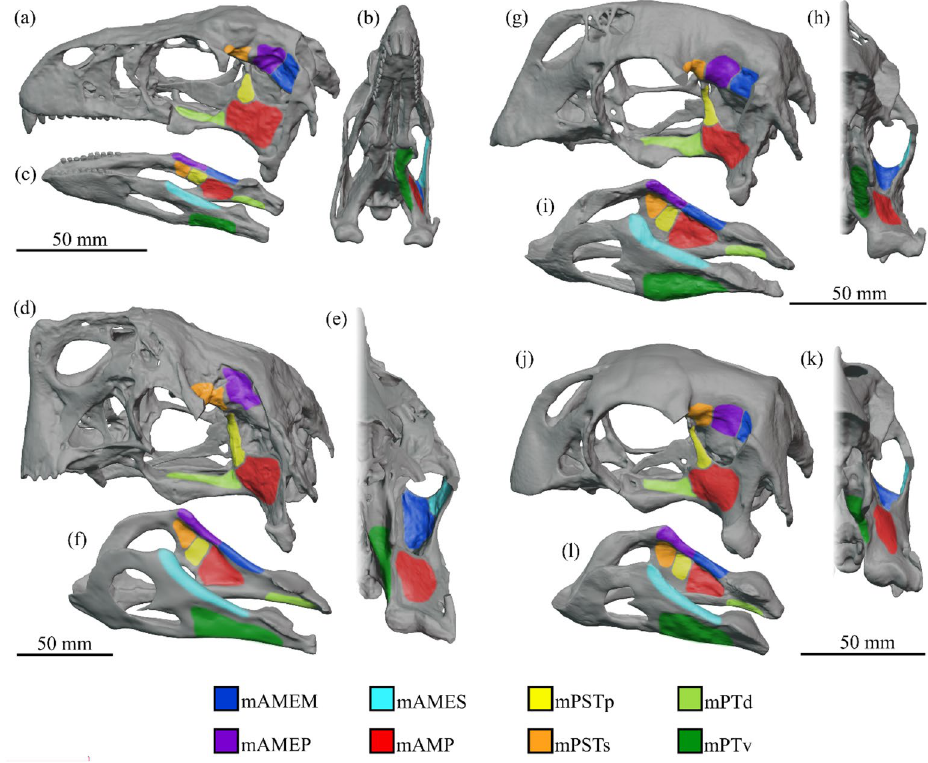
Figure 1. Locations of reconstructed jaw adductor muscle origin and insertion sites for Incisivosaurus gauthieri ( a - c ), Citipati osmolskae ( d - f ), Khaan mckennai ( g - i ), and Conchoraptor gracilis ( j - l ). Crania are shown in dorsolateral view ( a , d , g , j ) with temporal and postorbital bars removed to better show medial regions within supratemporal fenestra. The left sides of the crania are shown in anteroventral view ( b , e , h , k ) with lower temporal and postorbital bars removed to better show posterior and lateral regions within supratemporal fenestra. Mandibles shown in dorsolateral view ( c , f , i , l ), lateral muscle insertions sites are shown on the left rami, medial insertion sites on the right rami. Scale bars 50 mm. Muscle abbreviations given in results